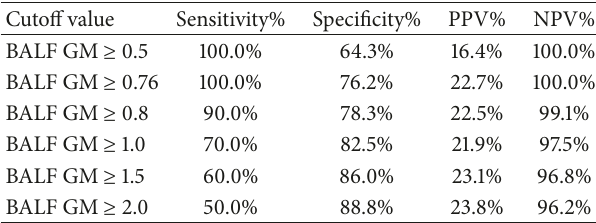
Table 1: Baseline clinical characteristics of the study population a . Table 2: Comparison of seasonal distribution, clinical symptoms, and chest CT between proven/probable IPA patients and non-IPA patients.